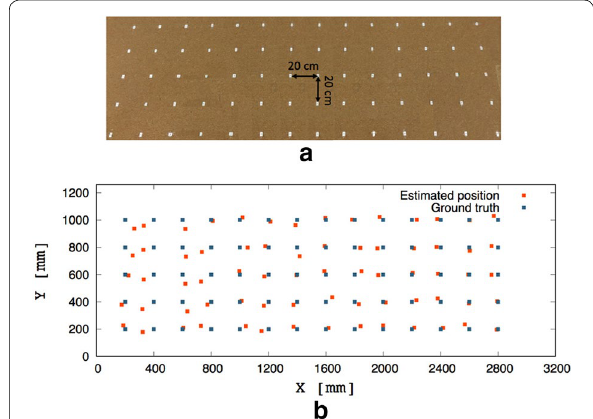
Fig. 10 Real-time self-localization at fixed points. a Experimental environment for estimating the location accuracy at 70 points (the white points are the chosen positions); b result of the estimation